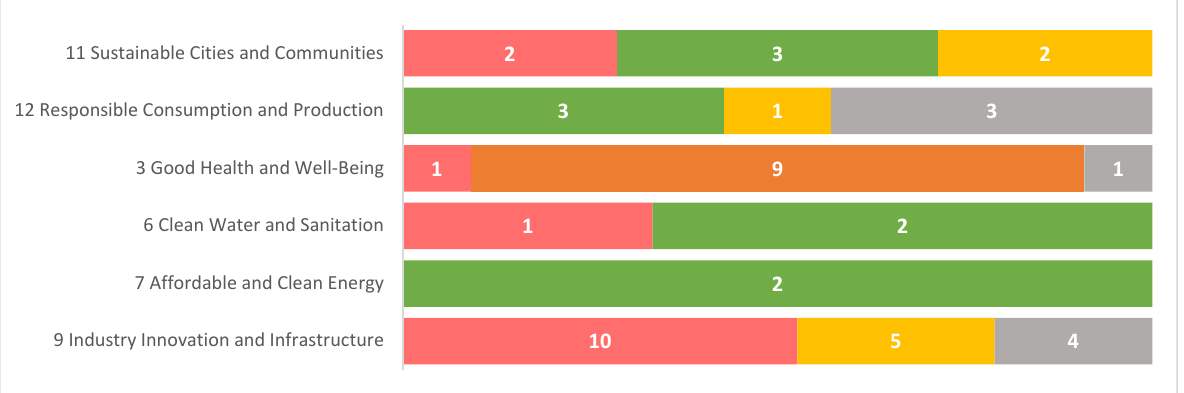
Figure 2. Sustainable Development Goals by research area. Source: own study.